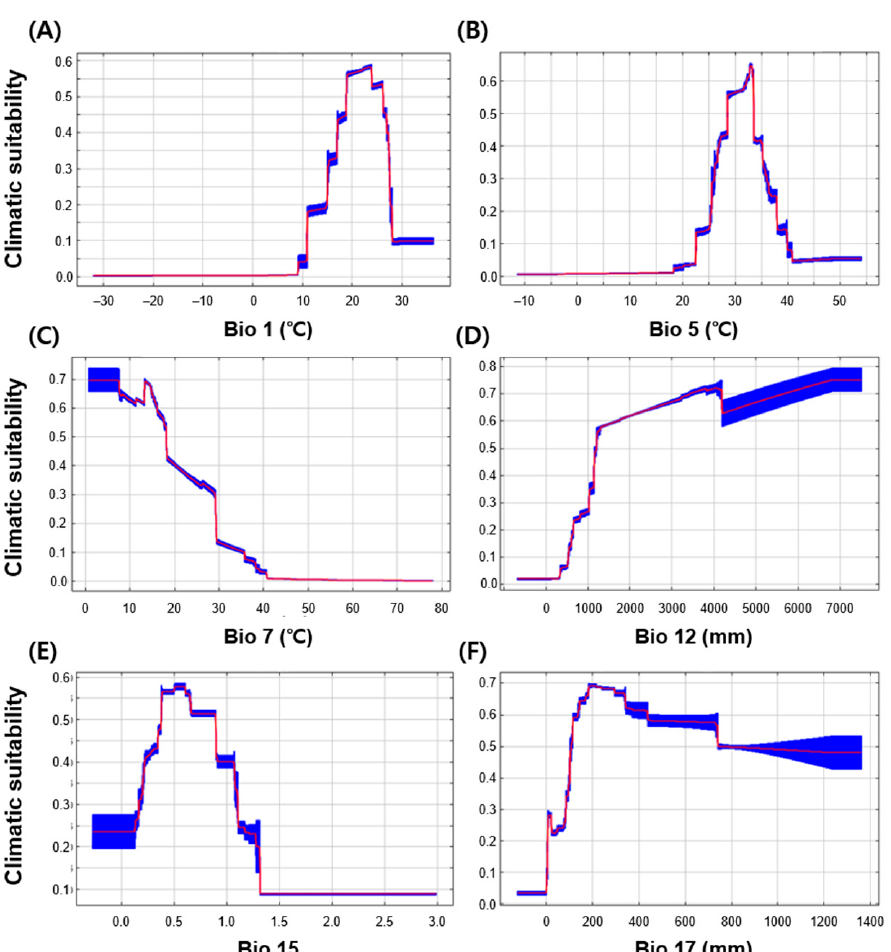
Figure 3. Response curves of MaxEnt model to changes in the six explanatory variables. Red lines and blue areas show the average and standard deviation of 10-fold cross-validation. ( A ) Bio 1: Annual mean temperature, ( B ) Bio 5: Maximum temperature of the warmest week, ( C ) Bio 7: Annual temperature range, ( D ) Bio 12: Annual precipitation, ( E ) Bio 15: Precipitation seasonality, ( F ) Bio 17: Precipitation in the driest quarter.